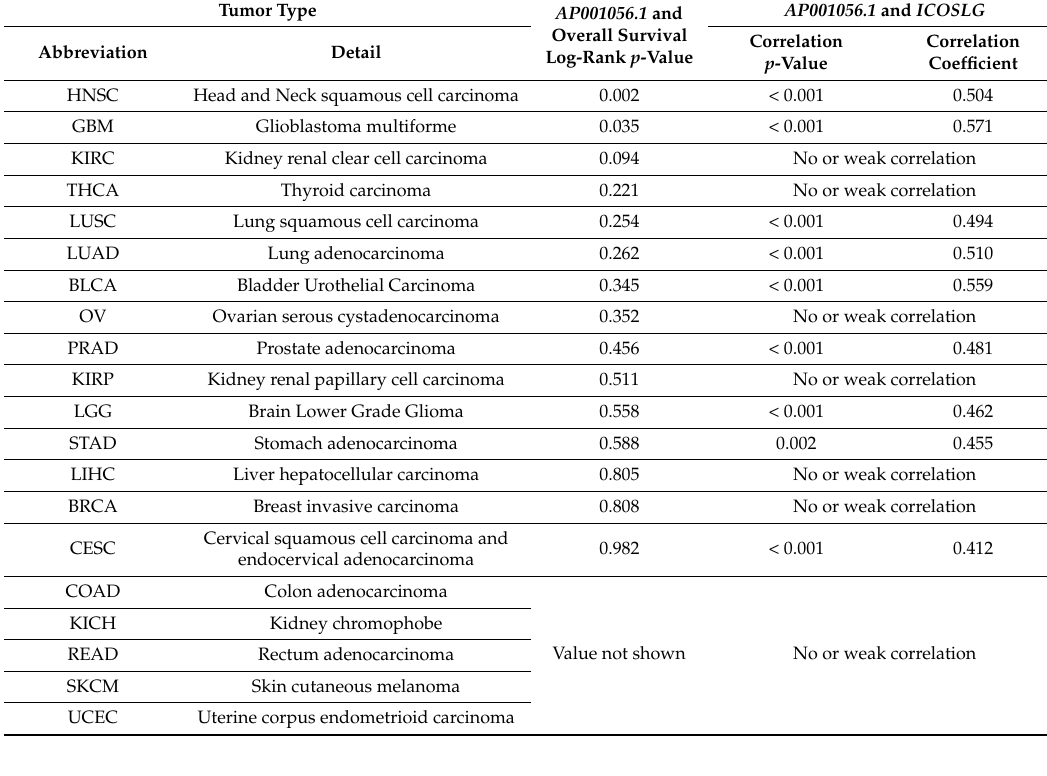
Table 2. TANRIC survival analysis and gene expression correlations for AP001056.1 and ICOSLG across 20 cancer types from the Cancer Genome Atlas (TCGA) project.